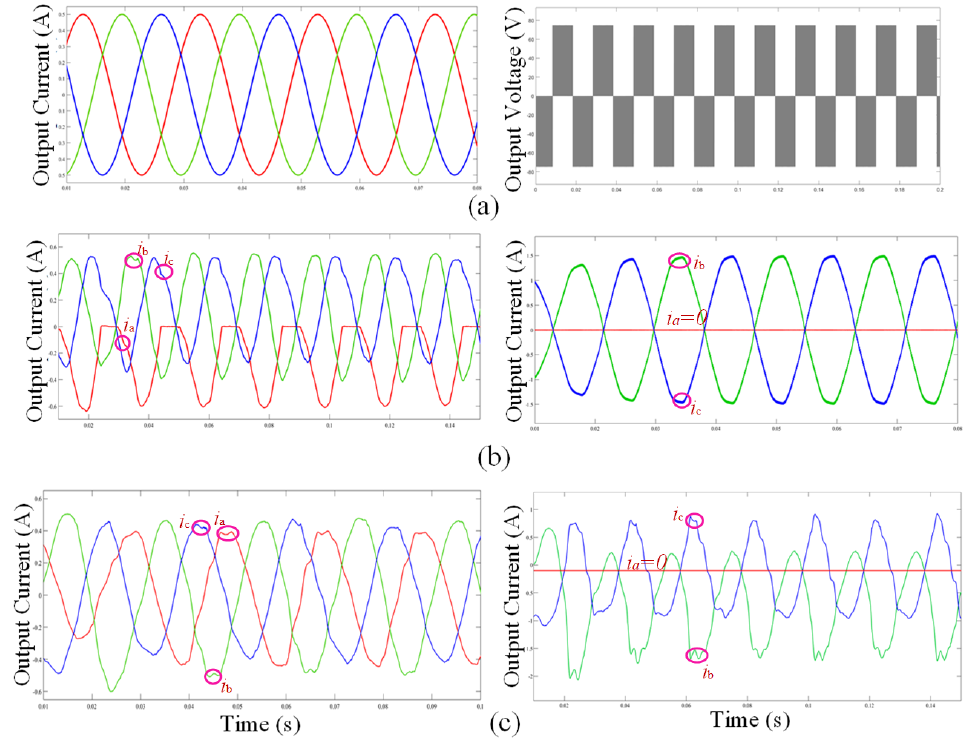
Figure 9. Simulation waveforms: ( a ) normal operation, ( b ) open-circuit fault, and ( c ) short- circuit